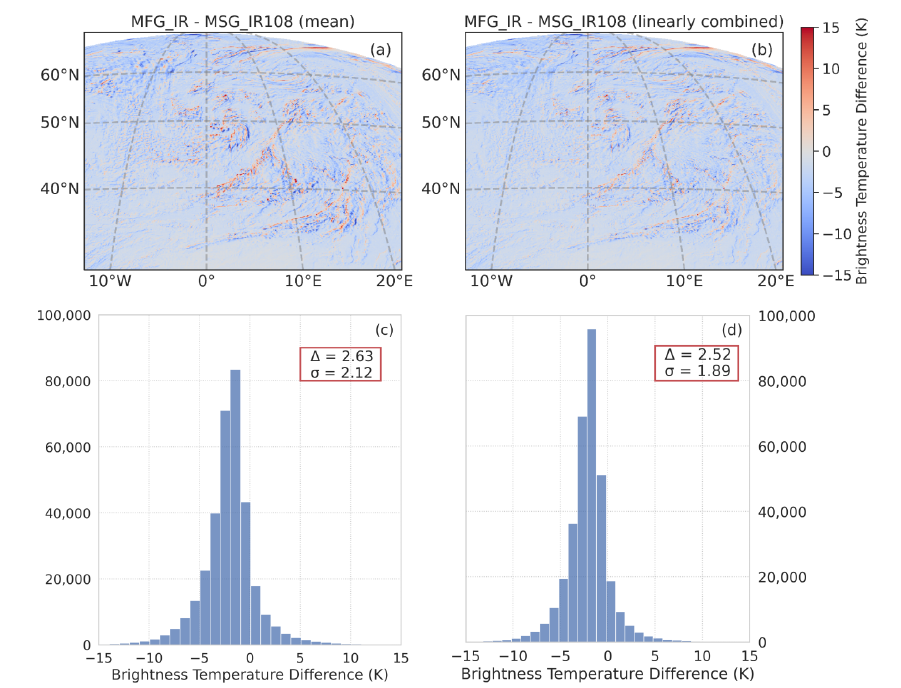
Figure 6. Difference between MFG original (IR channel) and temporally resampled MSG (IR 10.8 µm channel) scene for an example scene—1 January 2006, 09:00–09:30. ( a ) Difference with respect to the MSG scenes combined using mean BT values. ( b ) Difference with respect to the MSG scenes linearly combined (method adopted). ( c ) Histogram for difference shown in plot ( a ) with mean absolute shift ( ∆ ) of 2.63 K and standard deviation ( σ ) of 2.12 K. ( d ) Histogram for difference shown in plot ( b ) with mean absolute shift ( ∆ ) of 2.52 K and standard deviation ( σ ) of 1.89